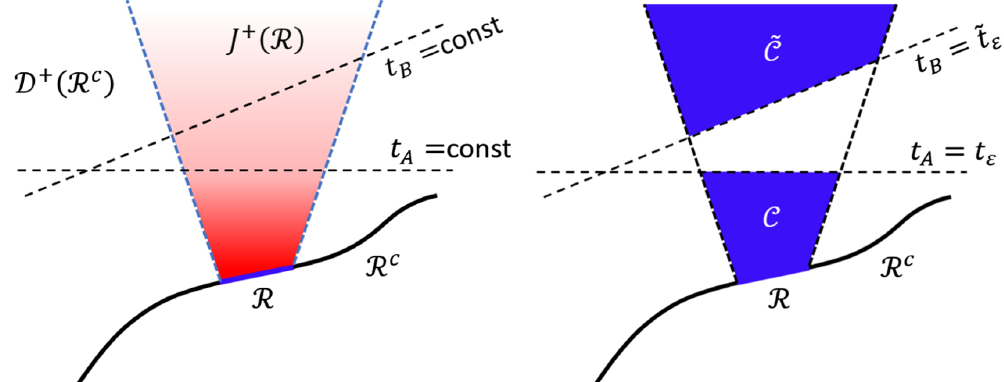
FIG. 3. Left panel: Minkowski diagram of a subluminal perturbation (in Alice ’ s coordinates). The blue segment is R , where the perturbation is initially located; the black line is R c , where the perturbation is absent. Together, R and R c constitute the initial-data hypersurface Σ . The shaded red region is J þ ð R Þ , where φ can propagate. The white region above Σ is D þ ð R c Þ , where φ ¼ 0 . The shades of red are a color map of φ (red large, white small). The hyperplanes at constants t oblique lines. Right panel: visualization of the sets C and